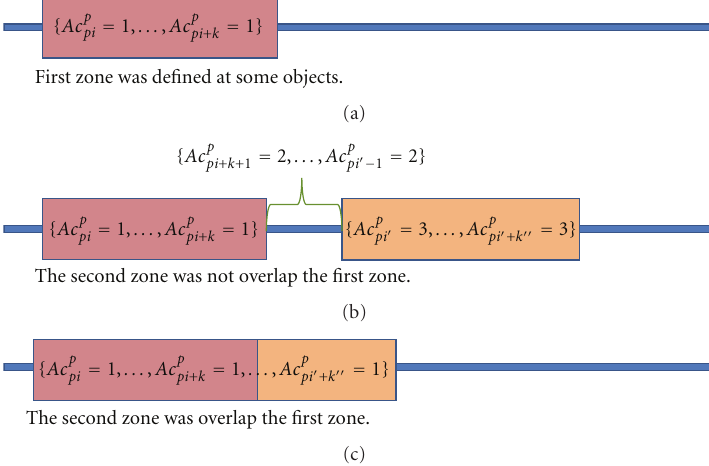
Figure 3: Generation of the zone. 3(a) shows a zone of “1” is used to define some of the objects. The second zone has two di ff erent cases. 3(b) shows the first case occurs where the second zone is not overlapping the first zone. The gap between these two regions is given a zone of “2”, where the two separated regions are assigned zones of “1” and “3”. 3(c) shows that the second case occurs when the second region overlaps the first